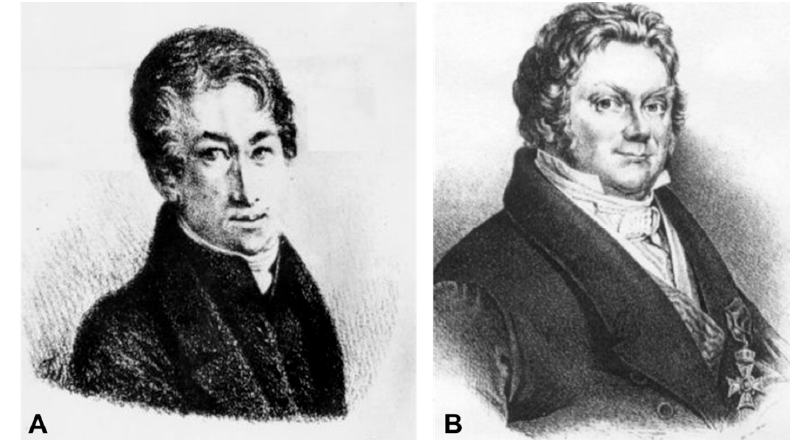
Figure 5. Mid-nineteenth century lithographs of the two Swedish chemists responsible for